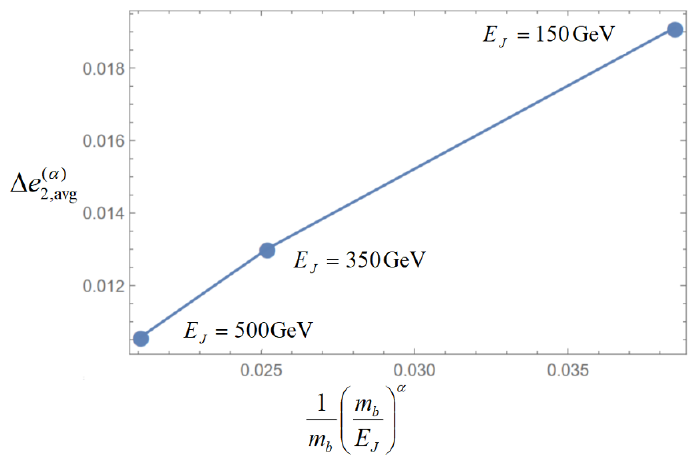
Figure 16 . The slope of the curve gives us a value of A ( (cid:11) ) = 0 : 5 GeV for (cid:11) = 0 :